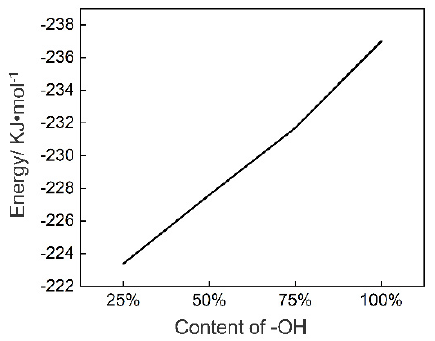
Figure 18. Di ff erent concentrations of hydroxyl Figure 18. Different concentrations of hydroxyl groups.